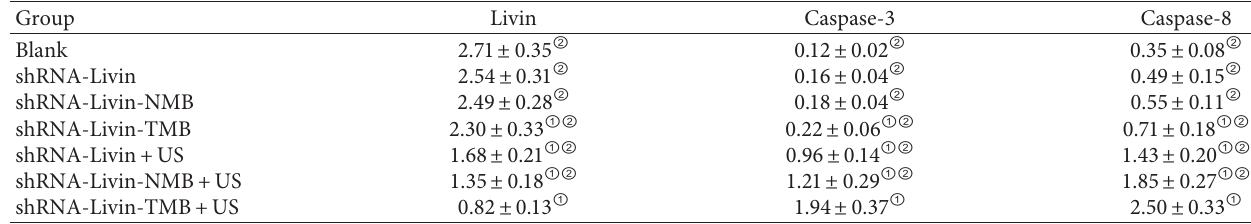
Table 3: The protein expression levels of Livin, caspase-3, and caspase-8 in each group.